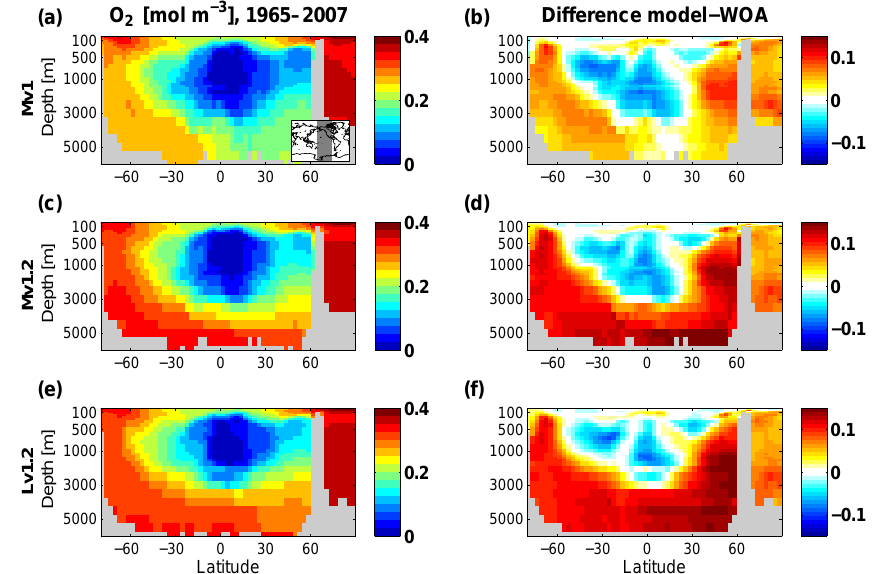
Figure 16. As Fig. 11 but for oxygen (molm − 3 ) along the grey shaded region in the Pacific/Southern Ocean indicated in the inset in panel (a)